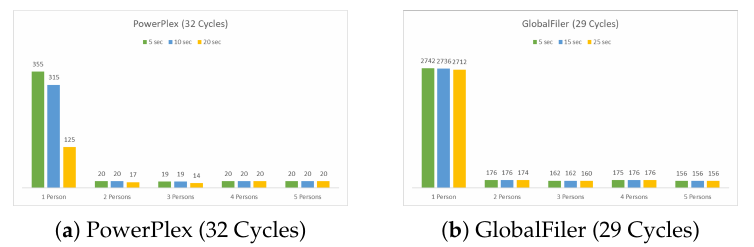
Figure 14. The number of profiles for PowerPlex and GlobalFiler